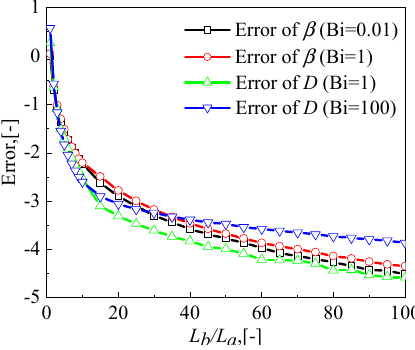
Figure 6. Errors of β and D with different Bi.